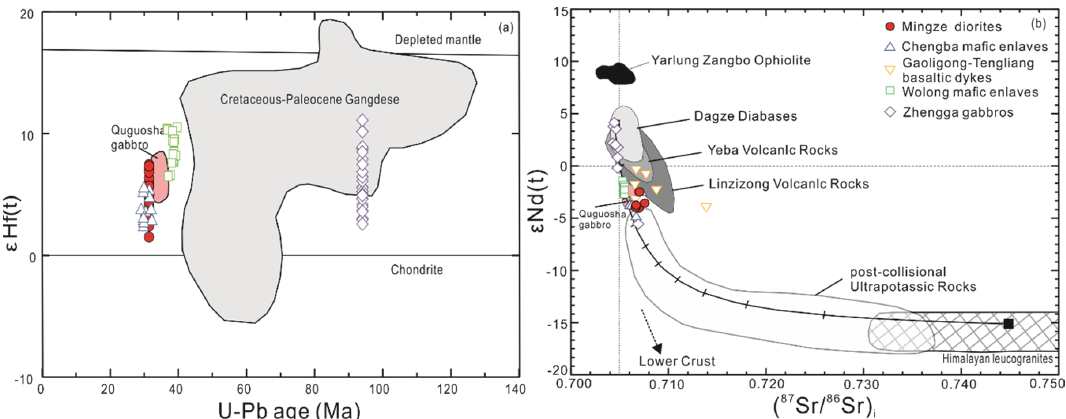
Figure 6. ( a ) ε Hf(t) values versus U-Pb zircon ages and ( b ) ε Nd(t) versus ( 87 Sr/ 86 Sr) i diagrams (after [16]) for the Mingze monzodiorites, southern Tibet. Data sources are as follows: